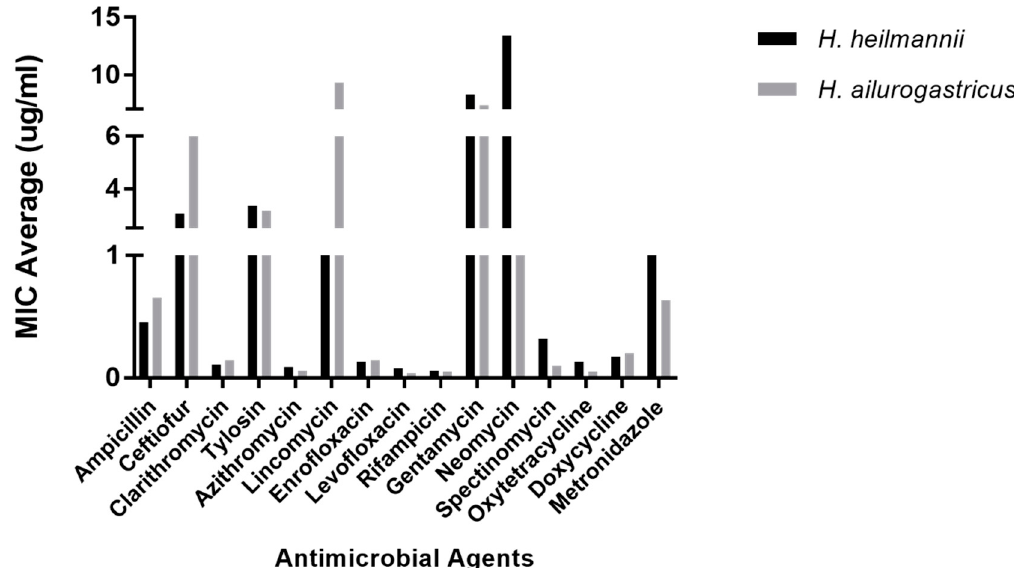
Figure 1. Graphical representation of distribution of MIC values of H. heilmannii and H. ailurogastricus isolates to the different tested antimicrobial agents. Statistical analysis was performed using the GraphPad software, but no significant differences were found between both species.